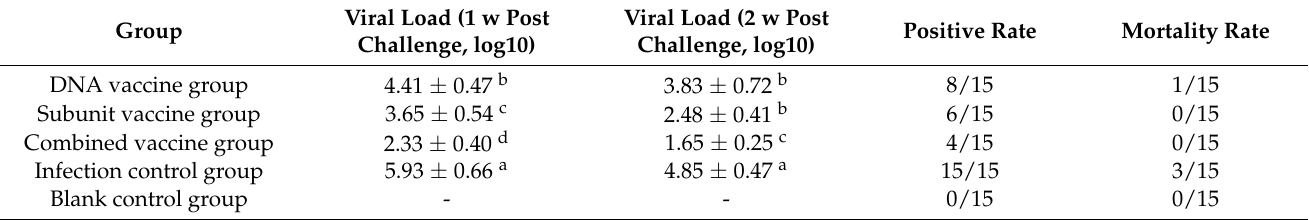
Table 6. Viral load, positive rate of CIAV, and mortality rate after CIAV